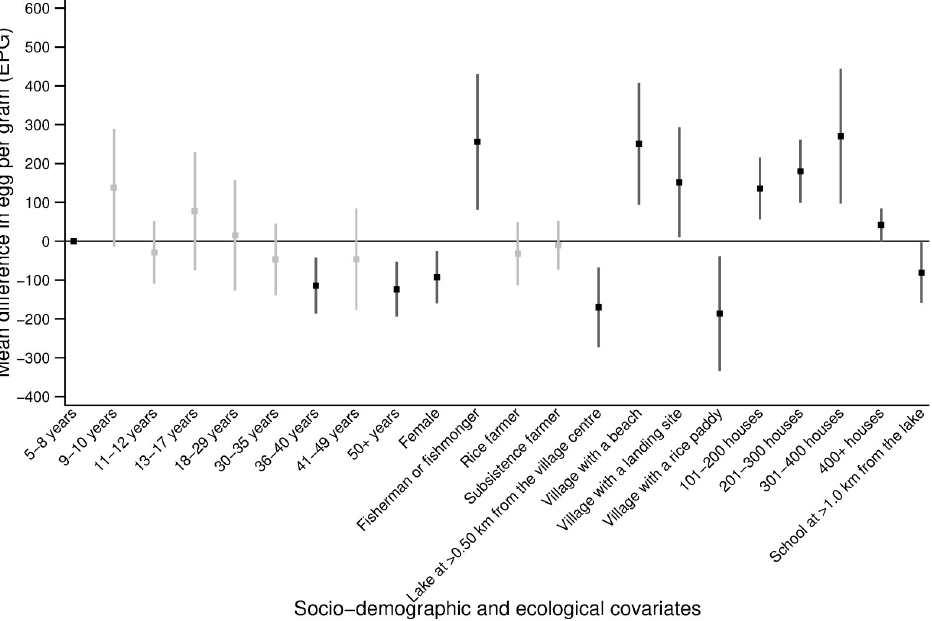
Fig 4. Predictors of the S . mansoni age-related infection intensity. Average change in eggs per gram (EPG), with the corresponding 95% confidence intervals (CI) from the negative binomial regression presented in S5 Table in S1 File. Only covariates that were chosen through likelihood ratio tests are shown in the figure. The black squares (lines) represent the average change in EPG (95% CI) for the statistically significant covariates (p-value � 0.05). The grey squares (lines) represent the average change in EPG (95% CI) for the non-statistically significant (p-value > 0.05) covariates. Note: only four villages have 400+ houses.